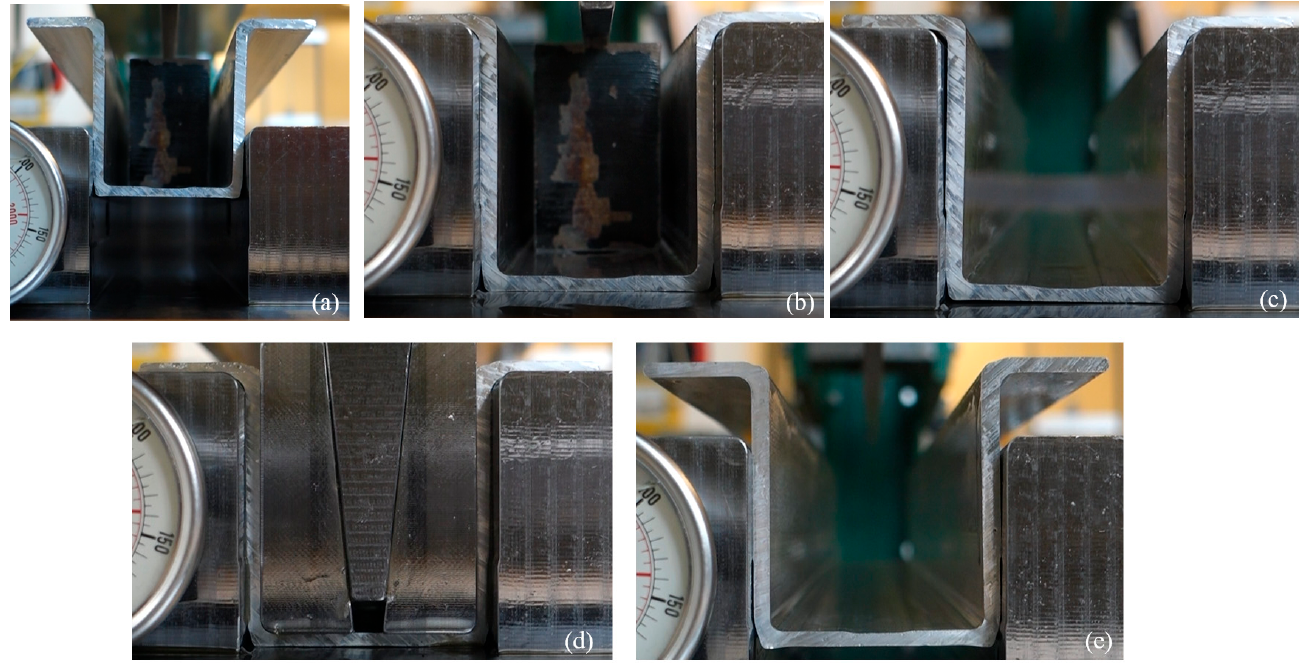
Figure 3. Dimension correction process: ( a ) initial geometry; ( b ) profile placement in die; ( c ) releasing; ( d ) calibration; and ( e ) final part geometry.